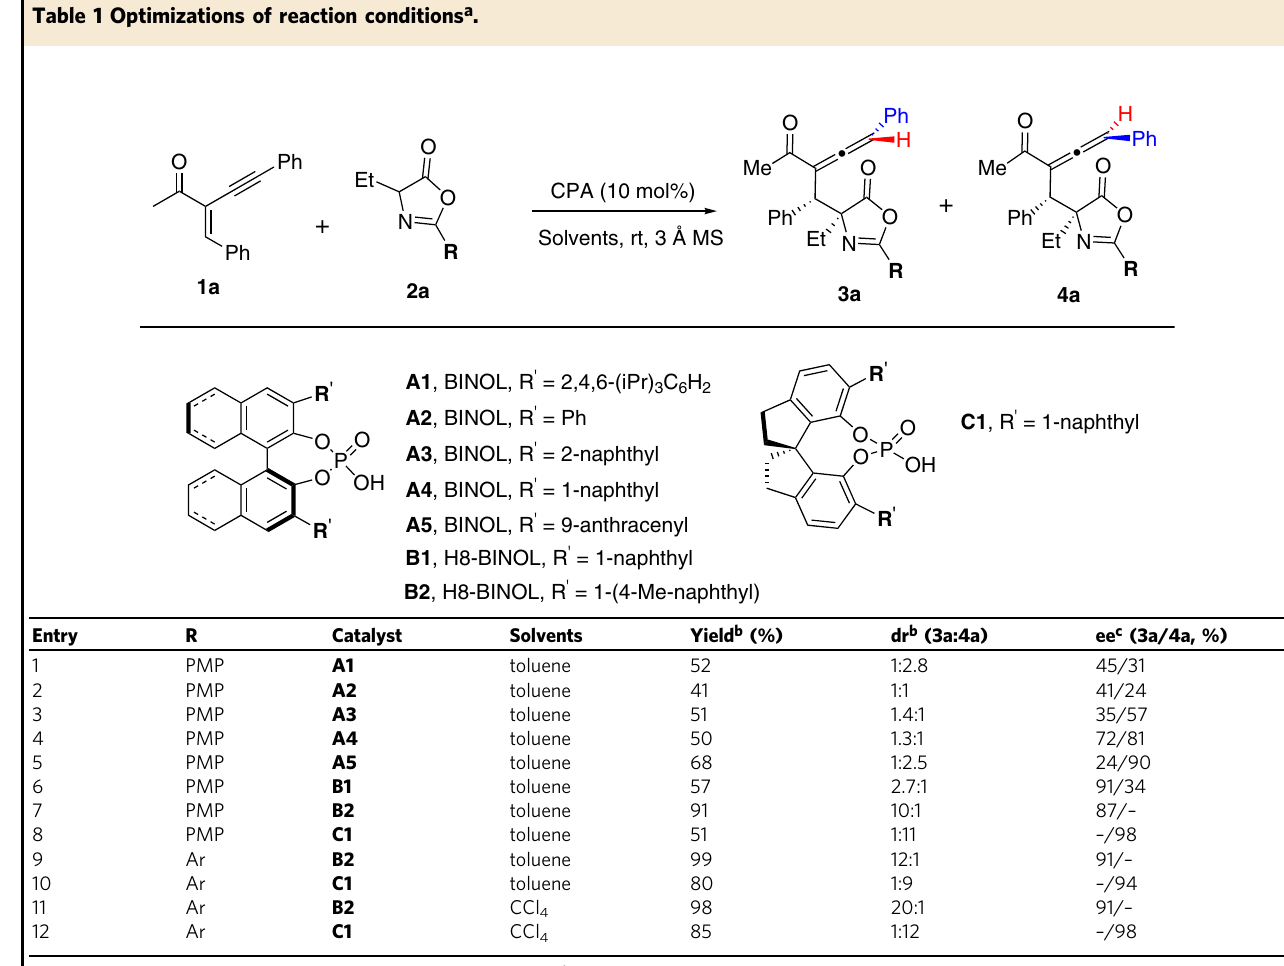
Table 1 Optimizations of reaction conditions a